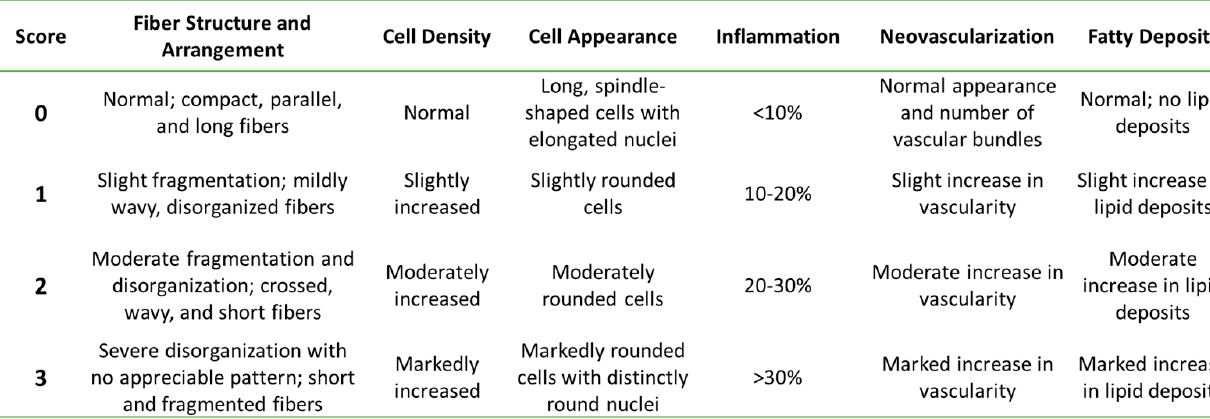
Figure 1. Histological grading scale as described by de Girolamo et al. (2019) [59].